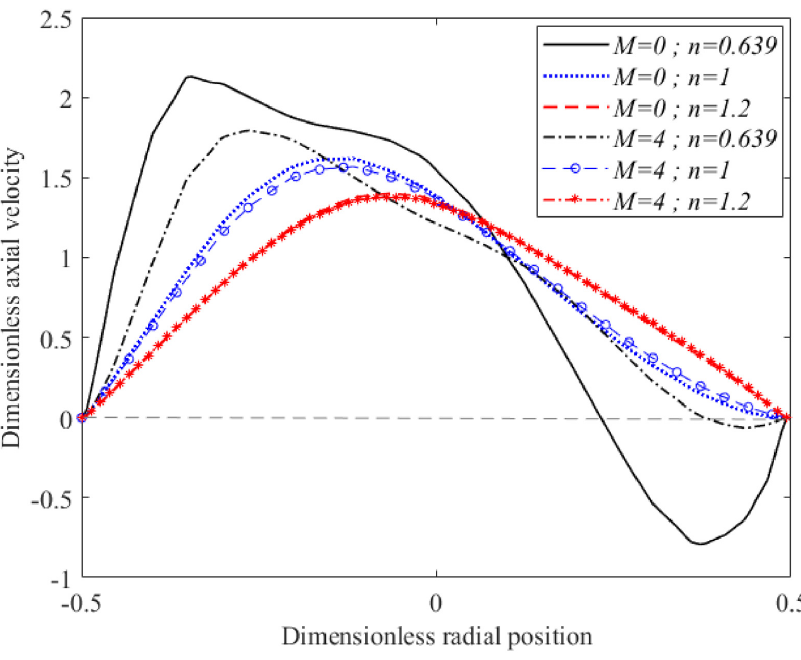
Fig 7. Variation of axial velocity at x = 3.0118 with different in Hartmann number and fluid characterisation (Re = 300 and τ = 0.4 a m